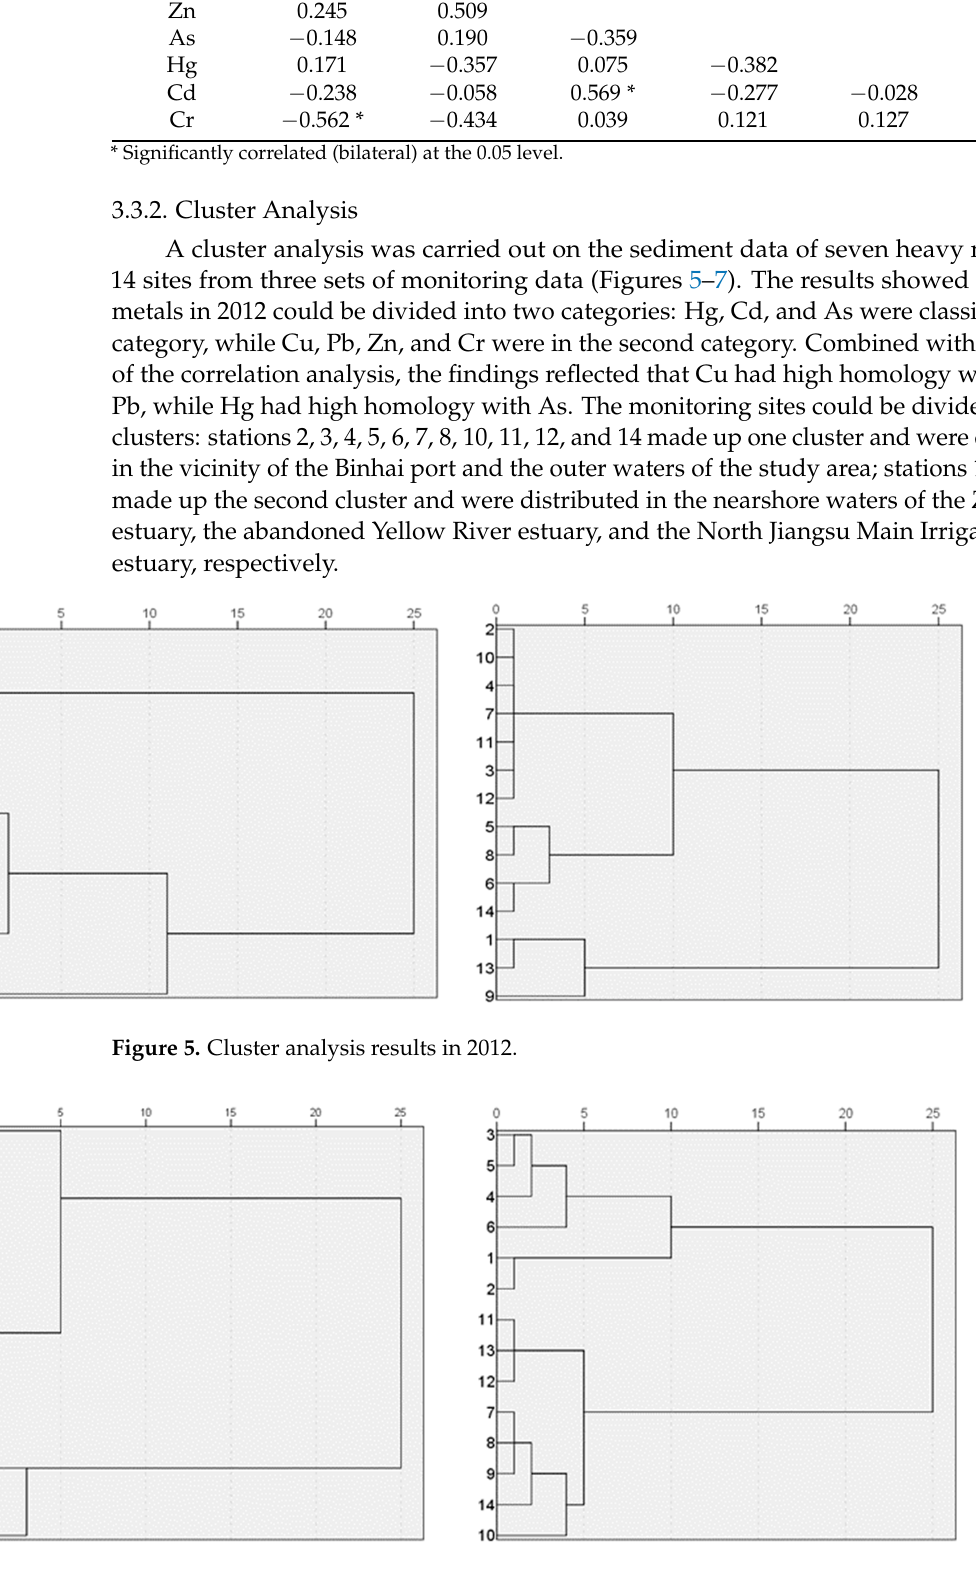
Figure 7. Cluster analysis results in 2018. 3.3.3. Spatial Variation of Heavy Metals in Sediments From 2012 to 2018, the contents of many heavy metals either declined or remained at the same level as that detected in previous years. However, Cd showed a significant up- ward trend. The content of Cr was low during the monitoring periods and mainly origi- nated from natural sources. There were high values of Cu and Pb in the Binhai port and its outer waters (Fi g ure 8). The pollution in the study area was serious in 2012, improved in 2015, and the high-value zone expanded in 2018, which may have been related to the increase in the development activities of the Binhai port and the large number of ships in recent years.